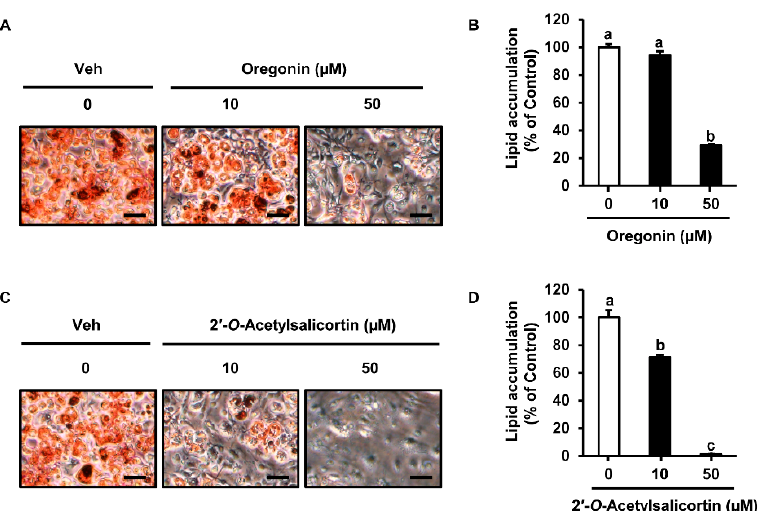
Figure 3. Inhibitory effect of oregonin and 2 ′ - O -acetylsalicortin on intracellular lipid contents. The 3T3-L1 preadipocytes were induced to differentiate and then treated with oregonin. ( A ) After differentiation, Veh or oregonin (10 or 50 µM)-treated cells were stained with Oil Red. ( B ) Lipid contents were quantified by spectrophotometry ( n = 3 per group). ( C ) Veh or 2 ′ - O -acetylsalicortin (10 or 50 µM)-treated cells were stained with Oil Red O solution. ( D ) Intracellular lipid accumulation was analyzed by spectrophotometry ( n = 3 per group). The values indicate the mean ± SEM. Mean values followed by different letters are significantly different ( p ≤ 0.05). The size of each scale bar in photomicrographs is 100 µ m. Veh, vehicle treatment (negative